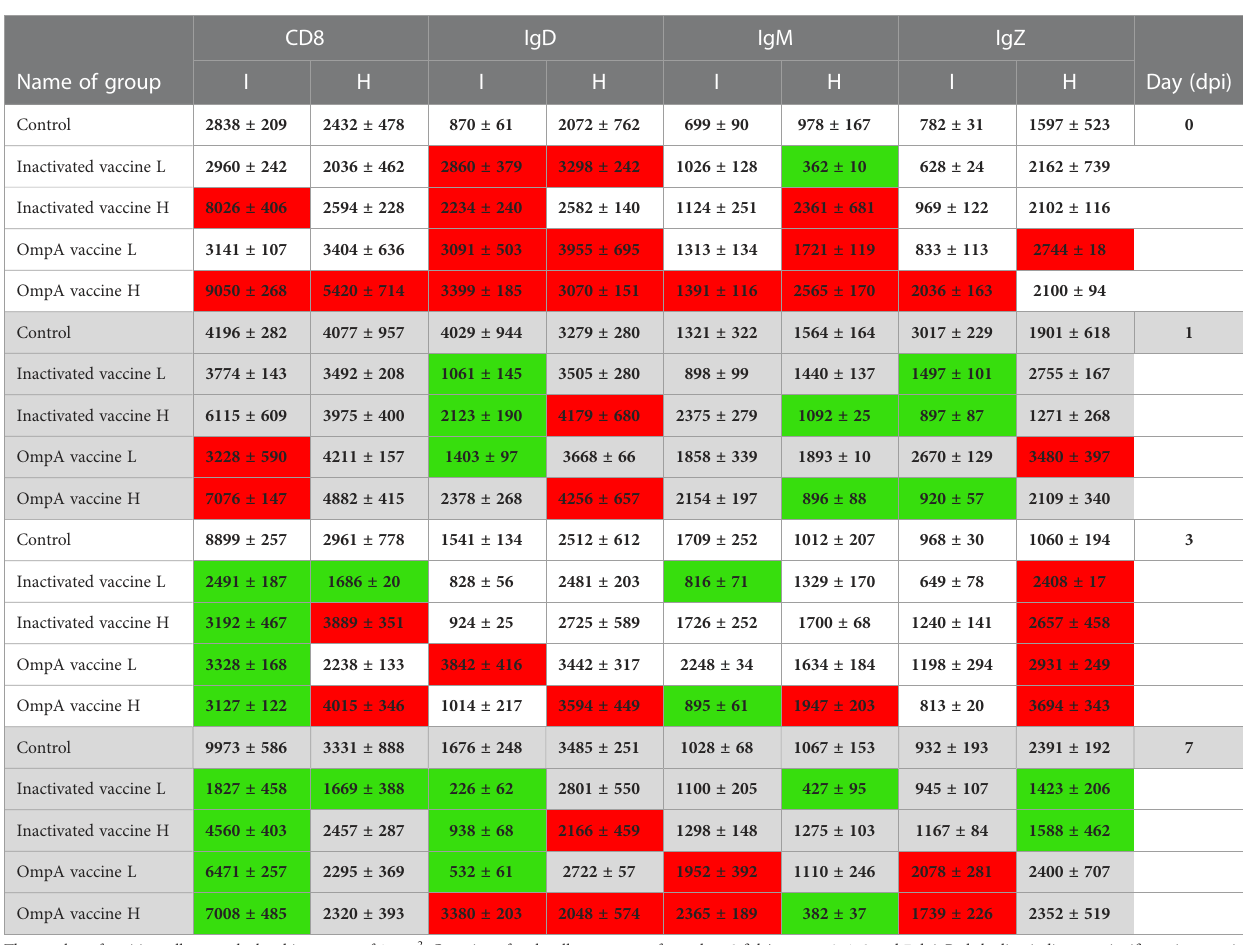
TABLE 3 IHC assay revealed the effects of vaccination on the number of immune positive cells in the hepatopancreas and intestines at different time points post infection.